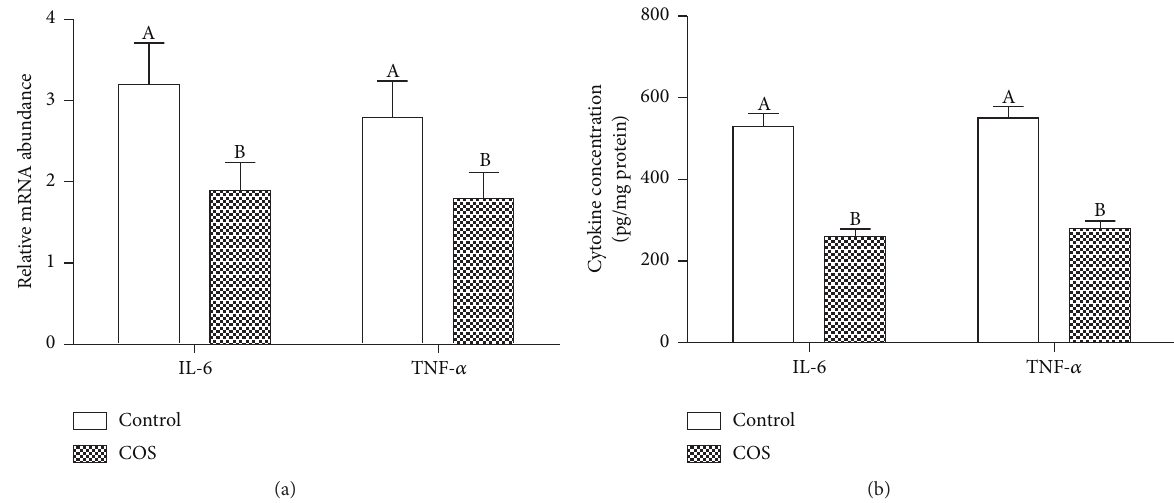
Figure 4: Control and COS group ( 𝑛 = 6 ) mucosal inflammatory responses. (a) RT-PRC evaluation of IL-6 and TNF- 𝛼 mRNA level. (b) ELISA evaluation of IL-6 and TNF- 𝛼 protein level.